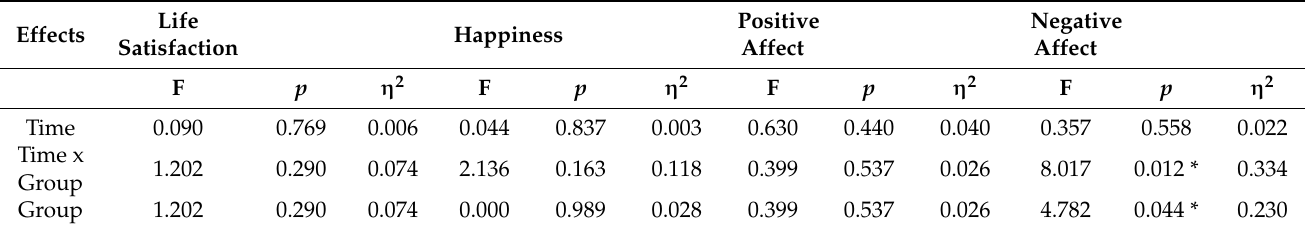
Table 4. Results of ANCOCAs for each component of psychological